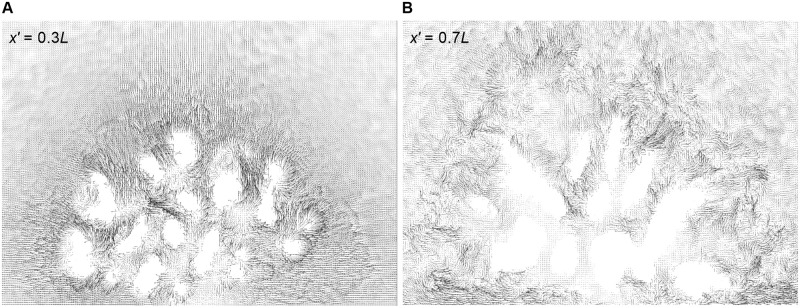
Front view of velocity vector fields at anterior and posterior cross sections of the P. meandrina colony.The vector fields were obtained at an upstream position inside the coral colony (x′ = 0.3L, left) and at a downstream position (x′ = 0.7L, right) relative to the front edge of the colony, where L is the colony length in the streamwise direction. The downstream vector field shows the formation of large vortices at the periphery of coral.